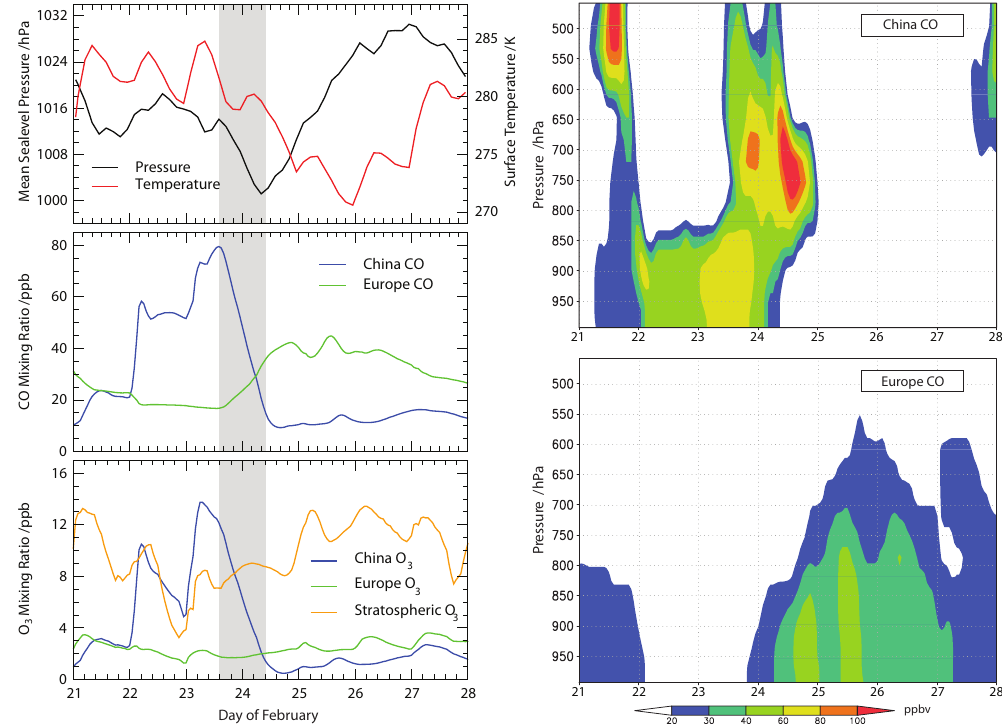
Fig. 13. Variations in surface pressure and temperature over Tokyo during the week of 21–28 February 2001, showing the passage of the frontal system shown in Fig. 12 (highlighted in grey) and the associated changes in the contribution of distant sources to O 3 and CO (left panels). Vertical profiles of the contributions of China and Europe to CO over Tokyo between the surface and 500 hPa (about 5 km) are shown in the righthand panels, highlighting the passage of the cold front on 24 February and elevated levels of CO from China aloft.